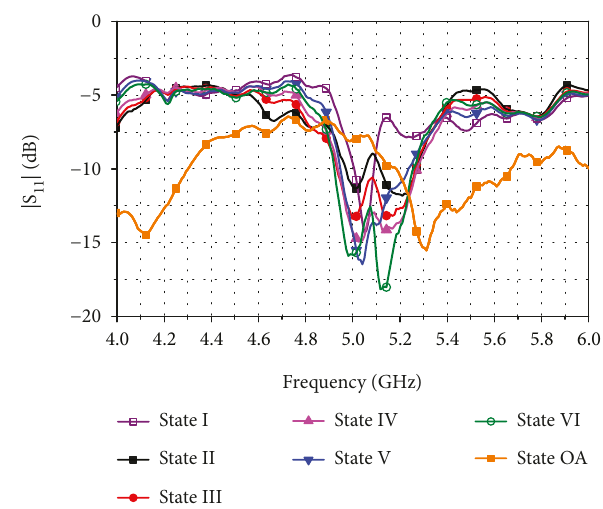
Figure 5: Re fl ection coe ffi cients of omnidirectional microstrip antenna with the di ff erent states of the p-i-n diodes and the original omnidirectional microstrip antenna.